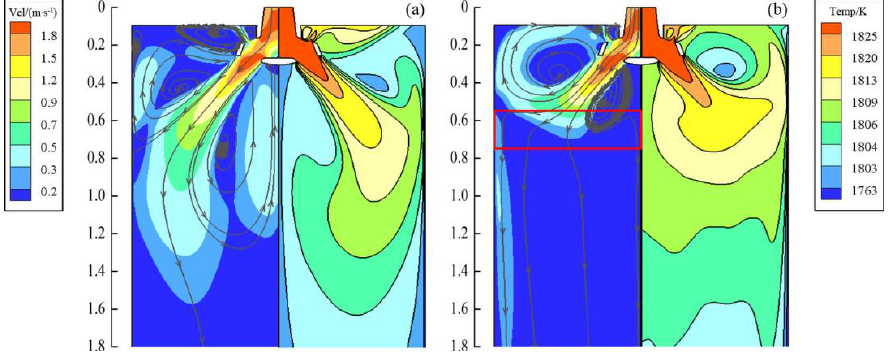
tribution of molten steel in the central plane of the FTSR mold thickness: ( a ) B max = 0 T and ( b ) B max = 0.5 T. ( b ) B max = 0.5